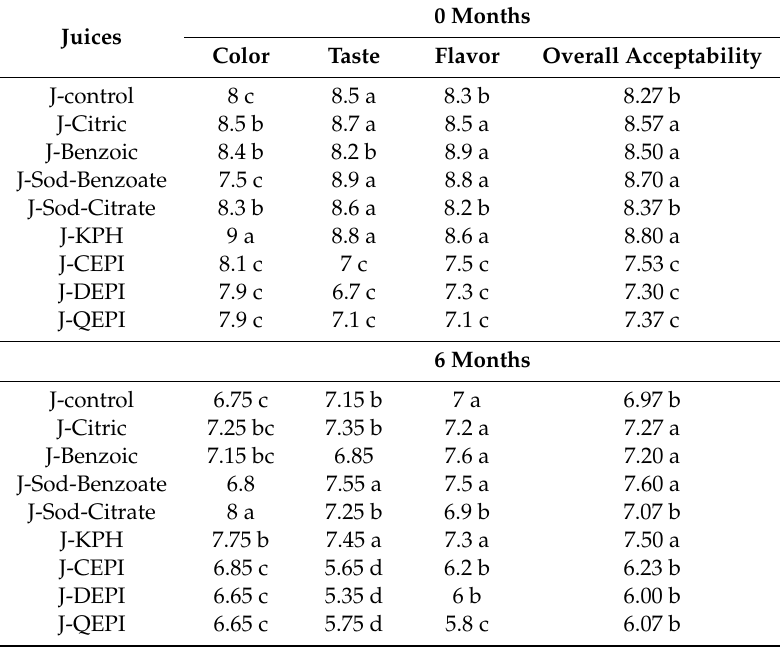
Table 5. Sensory properties of cucumber juices during the storage period. 0 Months Juices Color Taste Flavor Overall